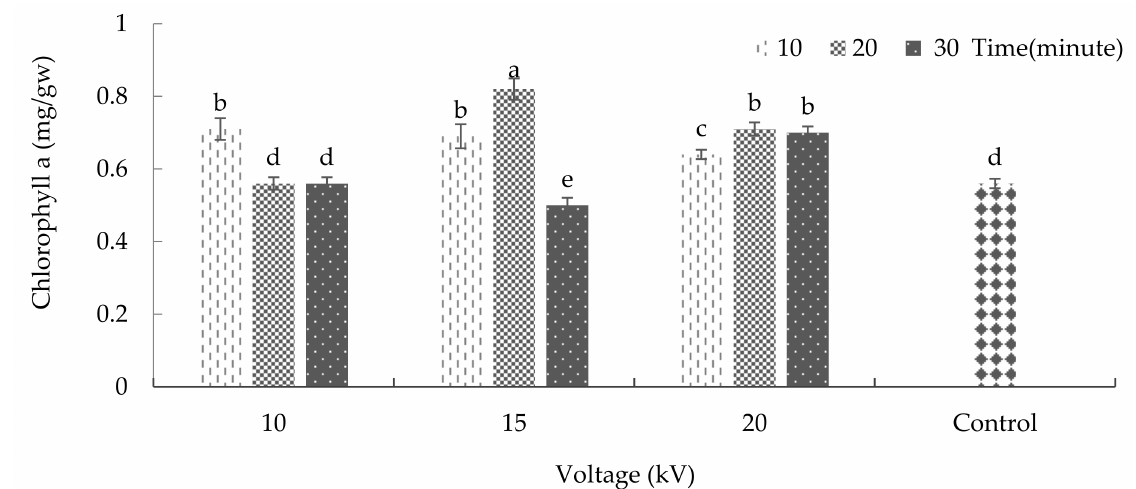
Figure 3. The effects of plasma on chlorophyll ‘a’ of basil. Error bars indicate standard error ( n = 3). Different lowercase letters denote statistical differences between treatment groups at the 5% level according to Duncan’s test.